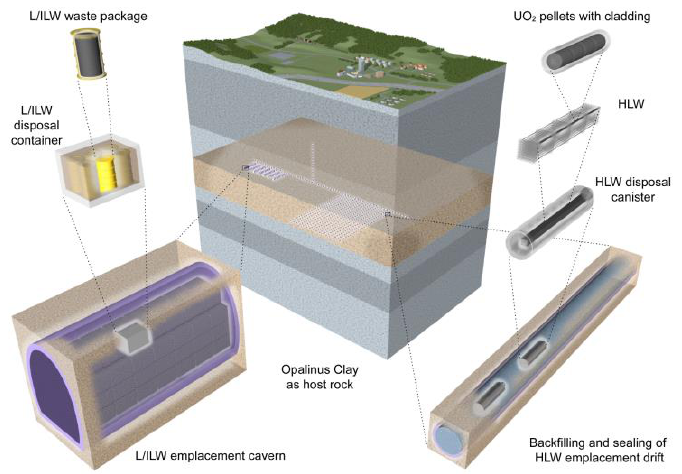
Figure 5. Layout of ILW/LLW and HLW and organization of safety barriers around them in geological disposal facility project [40].